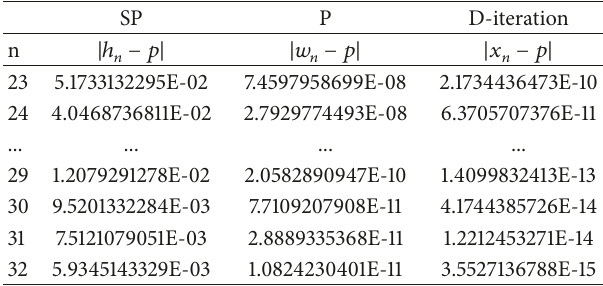
Table 2: The rate of convergence of SP-, P-, and D-iterations for 𝑓(𝑥) = (𝑥 2 + 2√𝑥 + 5)/8 .